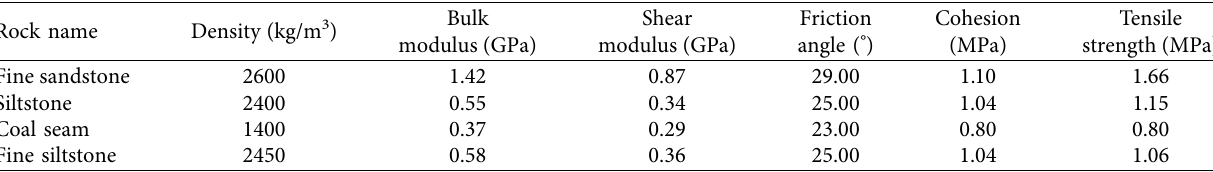
Table 1: Mechanical parameters of coal and rock.